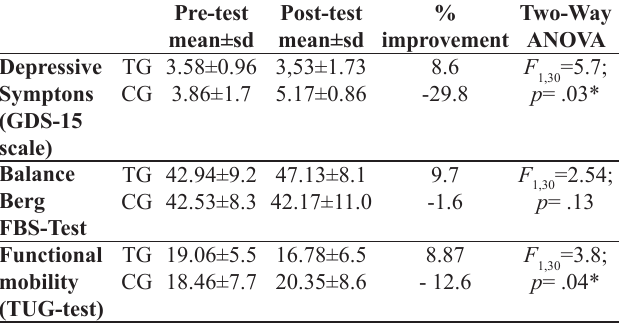
2. Results of depressive symptons balance and functional mobility from both pre- and post-test intervention and evaluated groups.